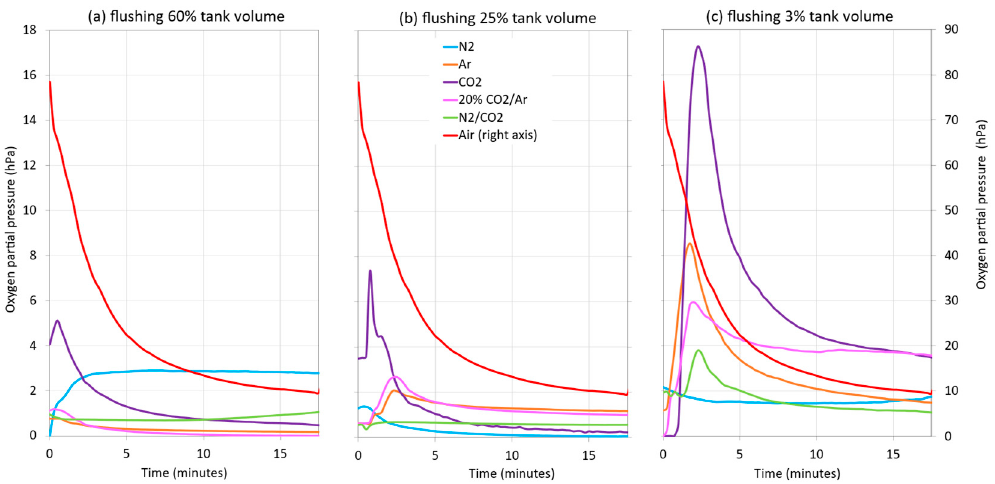
Figure 7. Influence of purging with different gases and reduction of gas blanket thickness on wine DO when filling the target tank during a wine racking with 60% tank volume, i = 0.6 ( a ); with 25% tank volume; i = 0.25 ( b ); and with 3% tank volume, i = 0.03 ( c ).